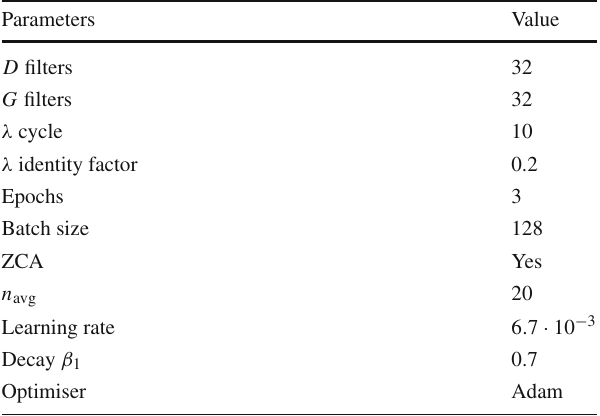
Table 2 Final parameters for the CycleJet model